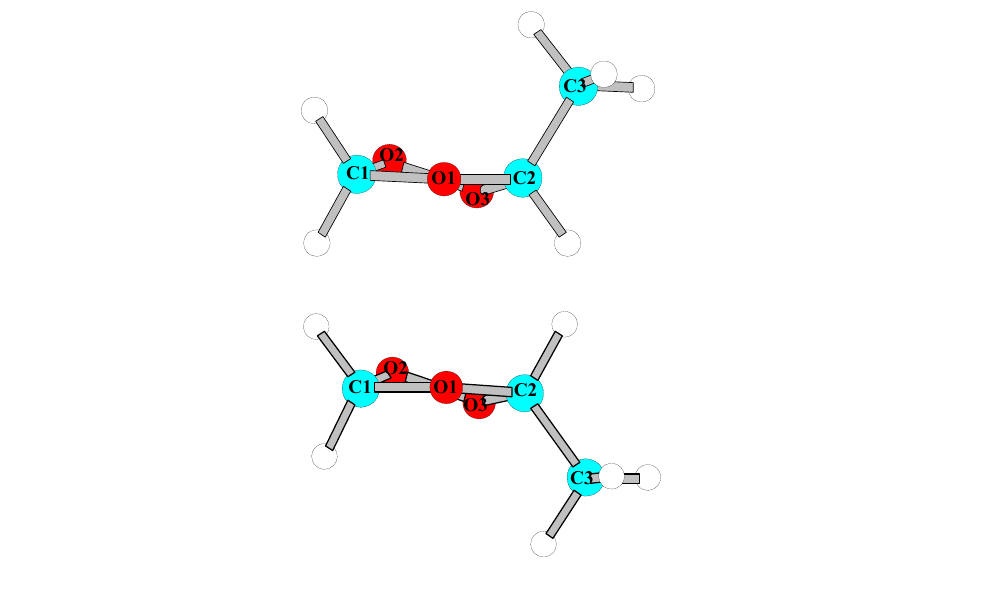
Fig. 4 Theoretically (B3LYP 6-311++G (3df, 3pd)) calculated structures of the staggered conformers of propene secondary ozonide. Top: O-O half-chair axial , τ (OOCC)= 87.8 ◦ ; Bottom: O-O half-chair equatorial , τ (OOCC)= 160.4 ◦ .